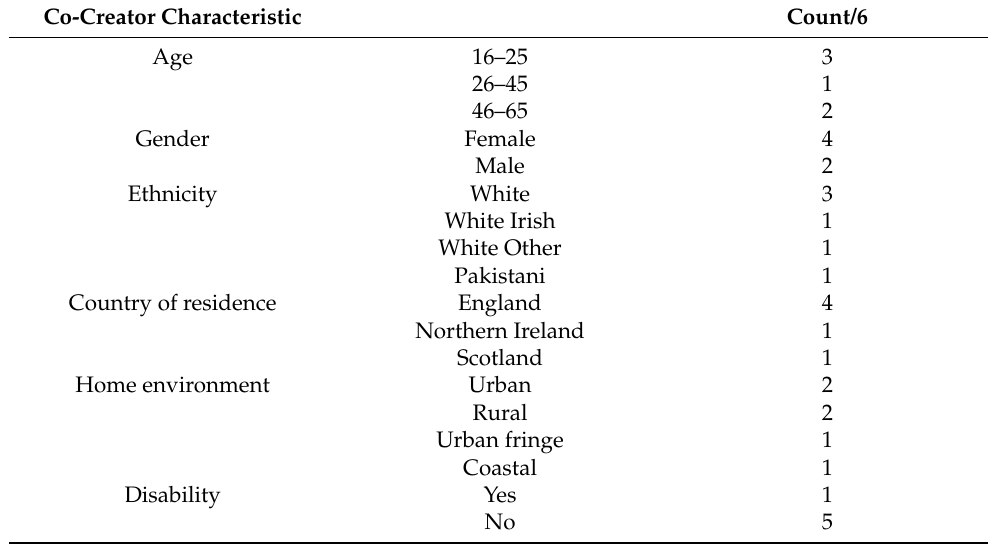
Table 1. Characteristics of co-creators as self-reported using an online survey. Co-Creator